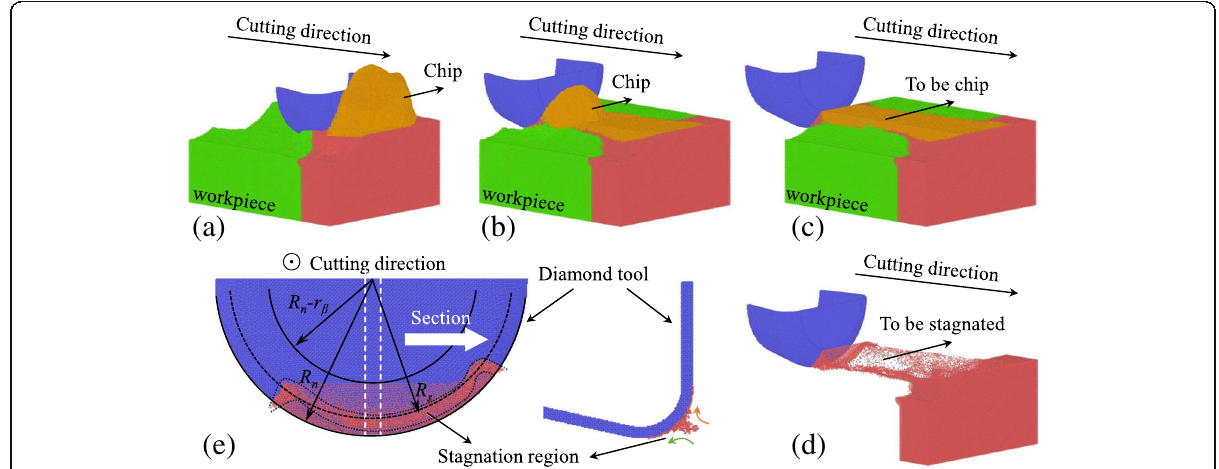
Fig. 2 Evolution of nano cutting process at cutting direction of {100} < 001>, tool edge radius of 5 nm and cutting distance of ( a ) 40 nm, ( b ) 10 nm, ( c ) 0 nm, and ( d ) the atoms to be stagnated, ( e ) forms the stagnation region on the cutting tool